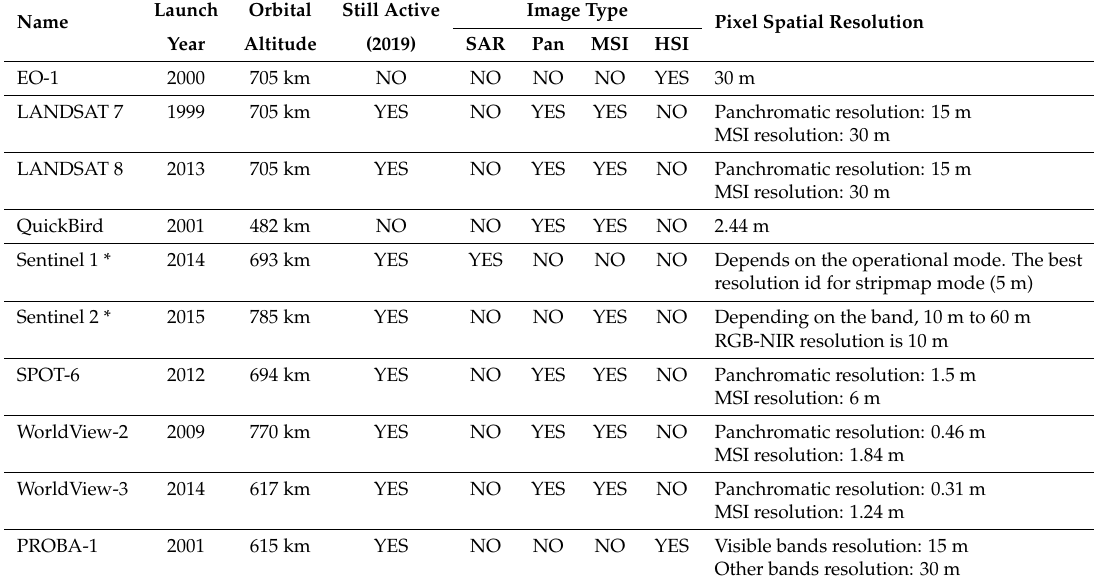
Table 1. A short overview of satellites and their remote sensing image products that have been frequently used in literature for deep learning practices.